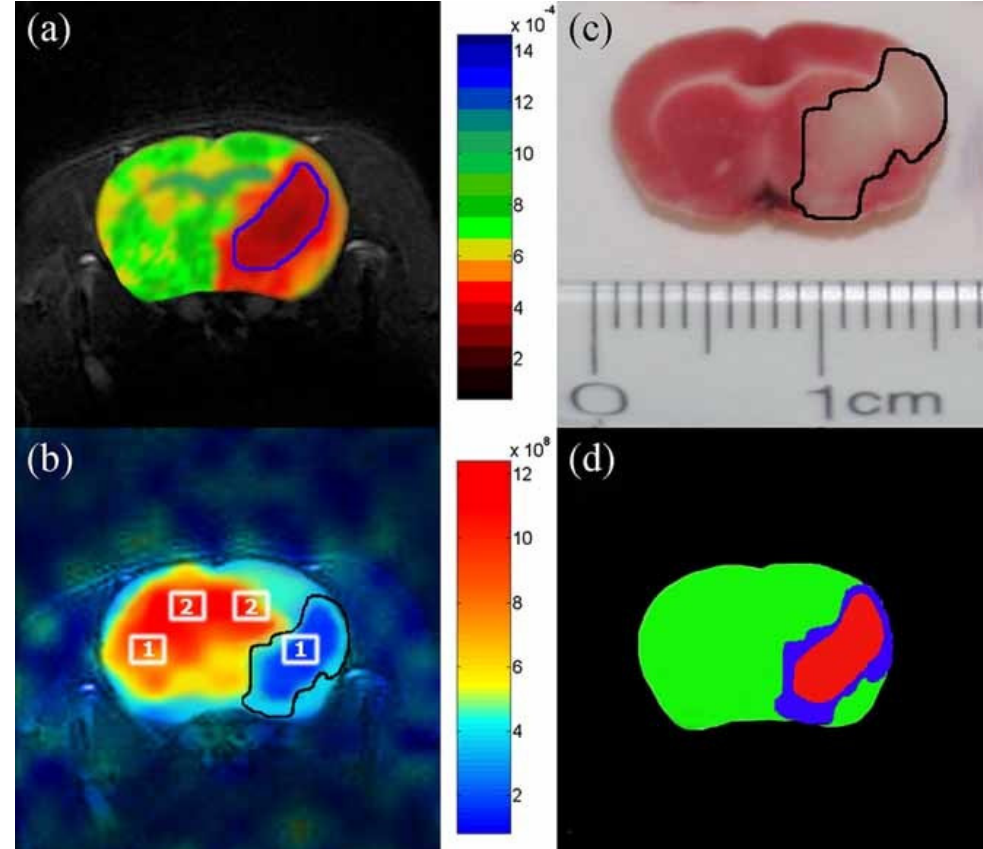
Figure 29. ( a ) Representative proton apparent diffusion coefficient (ADC) map image obtained 90 min after right middle cerebral artery occlusion (MCAO). The ischemic core is indicated by ADC values below 5.3 × 10 − 4 mm 2 /s (circled by a blue line). ( b ) Corresponding hyperpolarized 129 Xe chemical shift image (CSI). There is a large signal void in the ipsilesional (right) hemisphere. The defined regions of interest (ROIs) are labeled as follows: ROI1, core; ROI2, normal tissue. The xenon signal intensity is given in arbitrary units. ( c ) Corresponding 2,3,5-triphenyltetrazolium chloride (TTC)-stained brain section of the same animal as in ( a ) and ( b ). ( d ) Tricolor map based on the ADC and TTC images shown in ( a ) and ( c ). Green, red and blue represent nonischemic tissue, core and penumbra, respectively. Reprinted with permission from Zhou, et al. ( NMR Biomed 2011, ref. [109]).